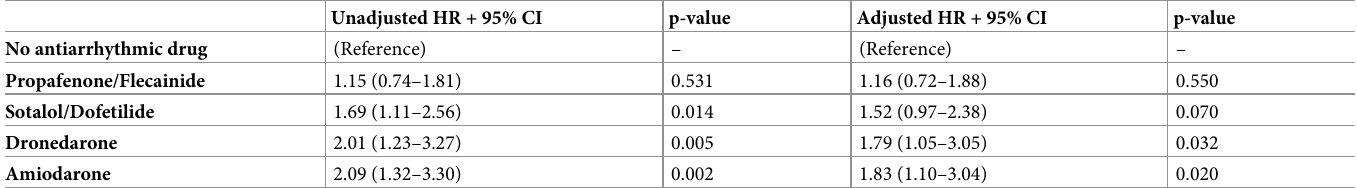
Table 3. Unadjusted and adjusted Cox proportional hazard ratios for late recurrence: AF/AFL/AT recurrence excluding three-month blanking period (No AAD is reference group). Unadjusted HR + 95% CI p-value Adjusted HR + 95% CI p-value No antiarrhythmic drug